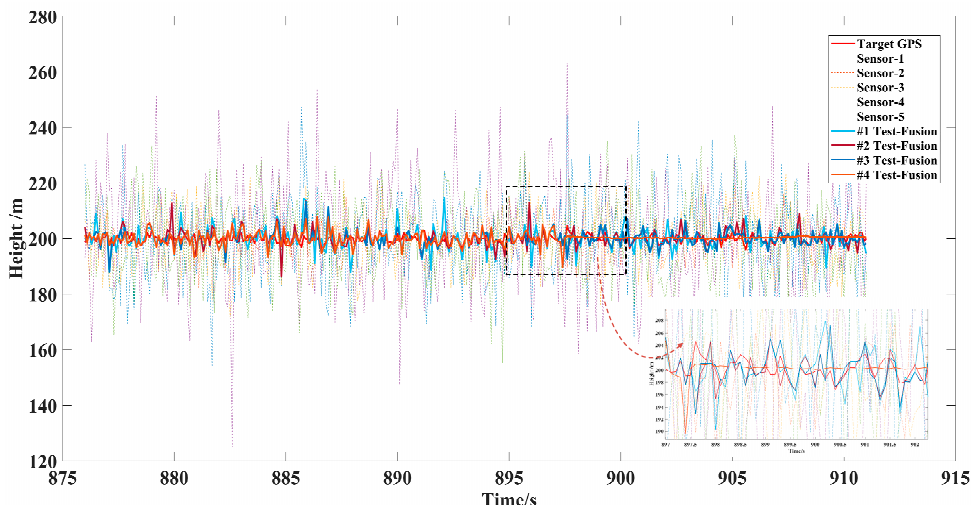
Figure 9. Latitude error of multisensor data fusion target trajectory.